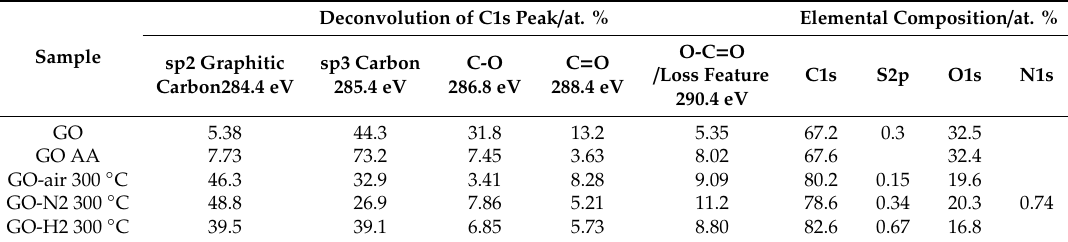
Table 1. Deconvolution of the C1s peak and elemental composition from XPS spectra.